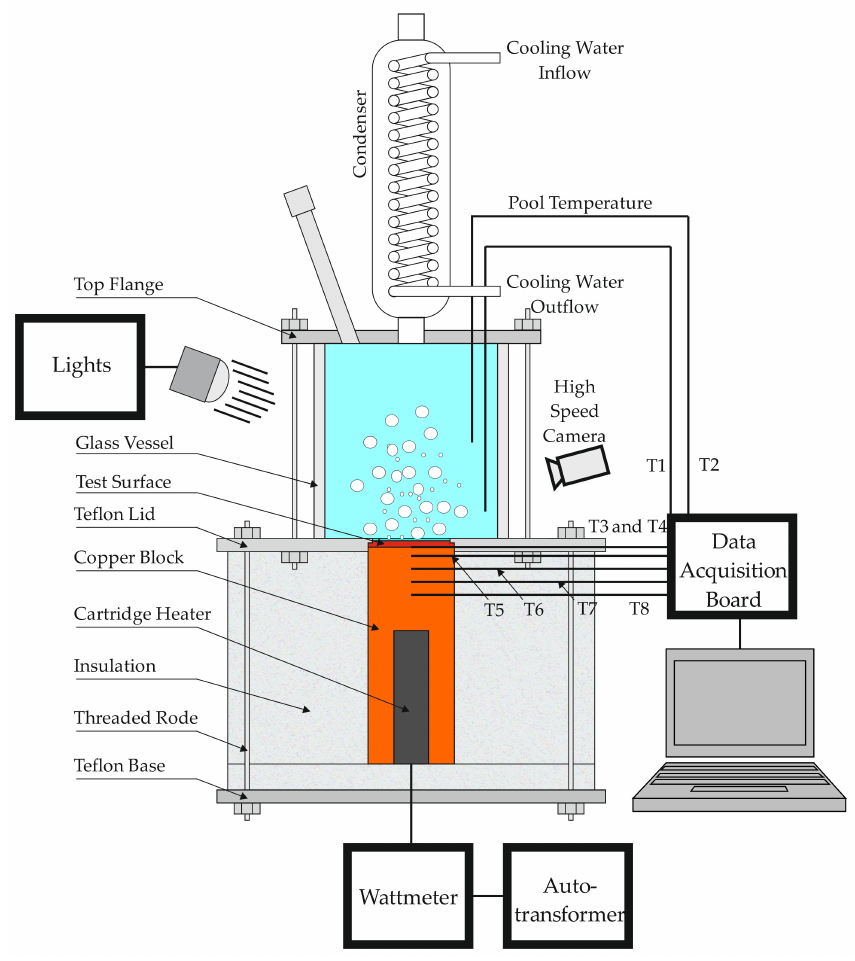
Figure 1. Pool boiling measurement